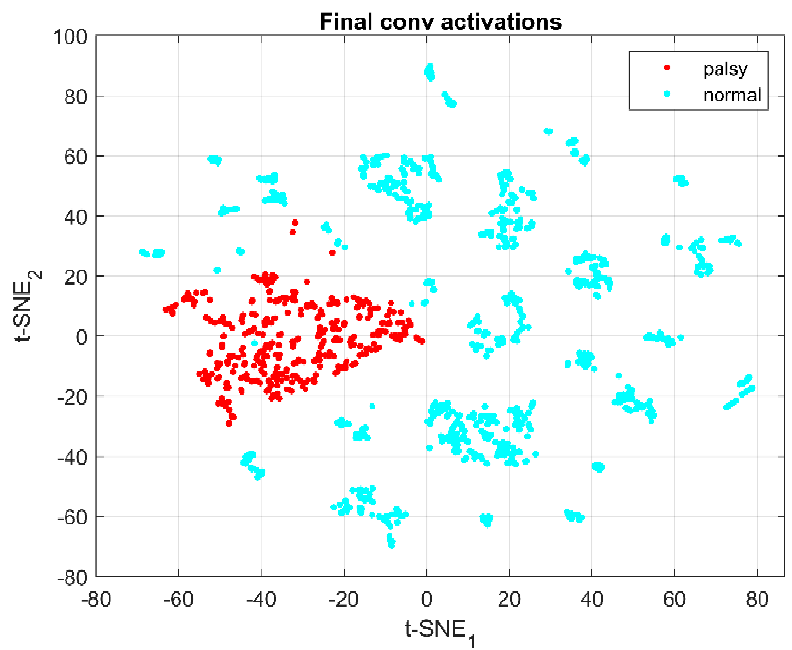
Figure 9. Data visualization using mapping into two dimensions using t-distributed stochastic neighbor embedding (t-SNE).